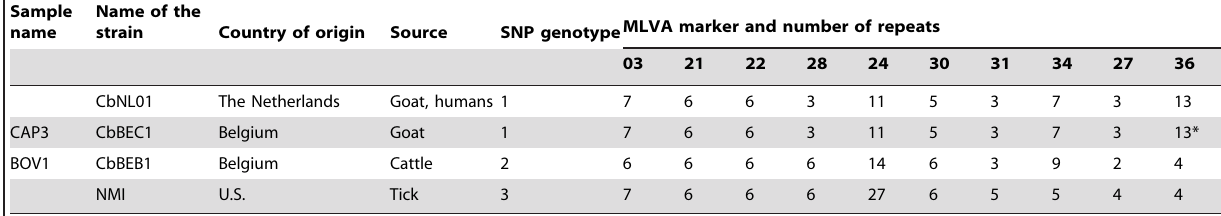
Table 1. List of C. burnetii isolates used in this study.